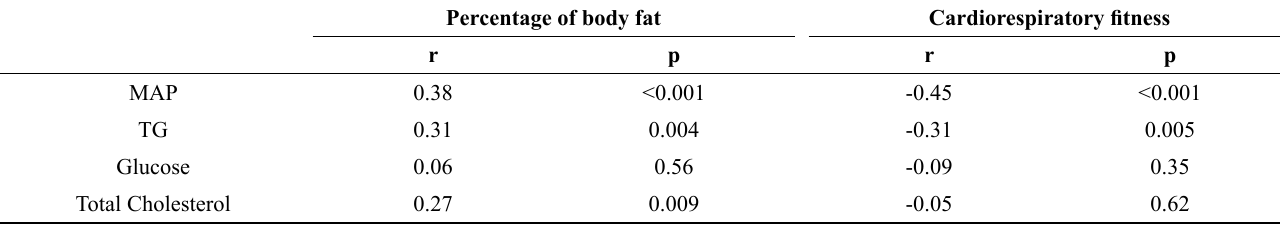
Table 2. Partial correlation between body fat percentage and CRF with cardiovascular risk factors in children